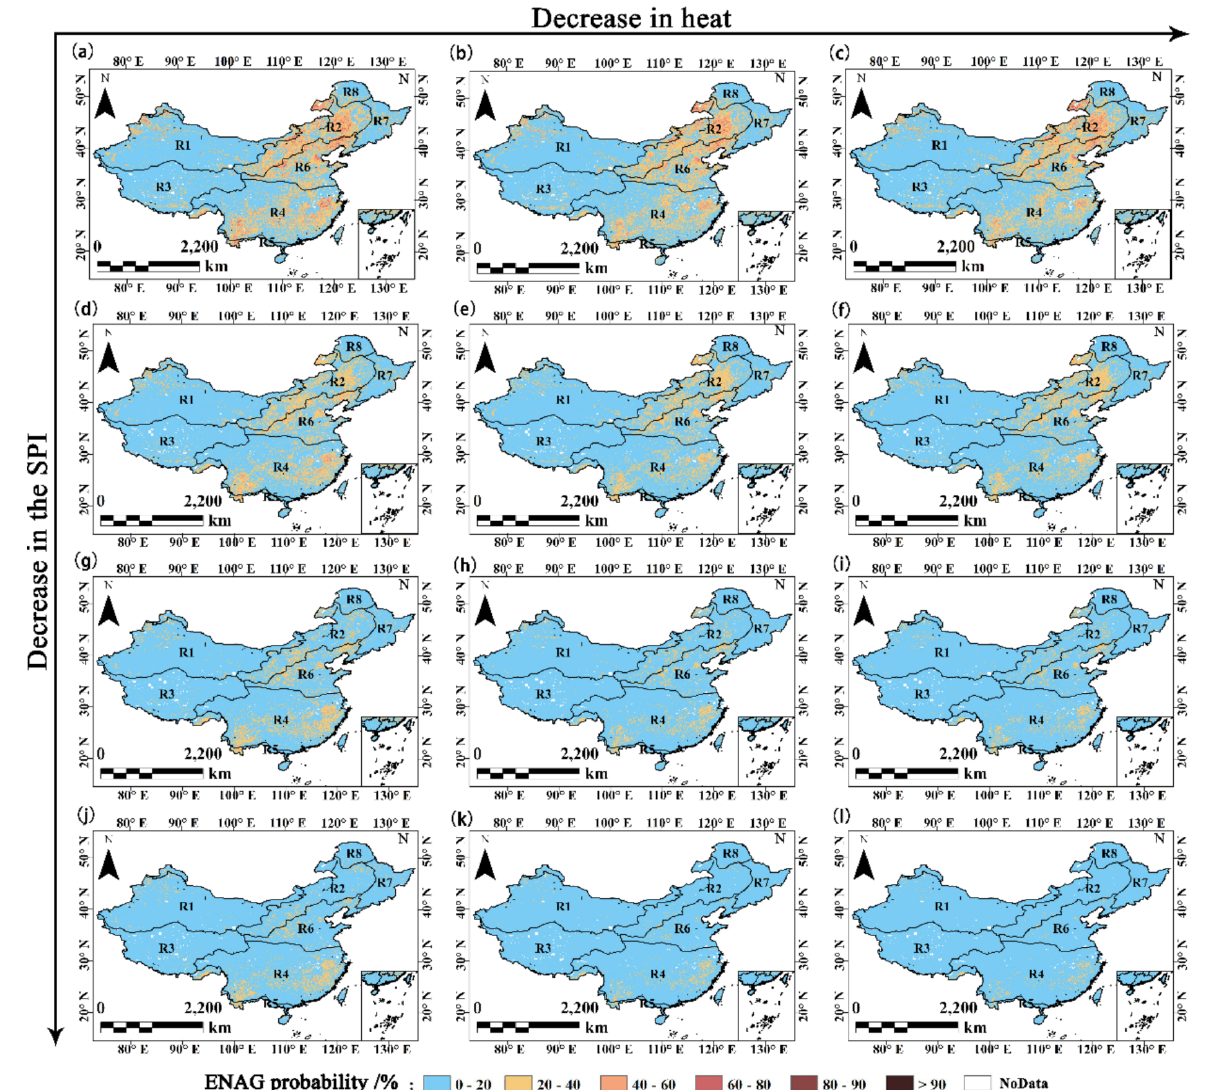
Figure 7. Spatial distributions of ENAG probabilities under different drought levels and different heat intensities. From left to right, the heat intensities decrease from severe to mild, and from top to bottom, the drought levels decrease from extreme to mild (Note: the pixels displayed in white have the same meaning as Figure